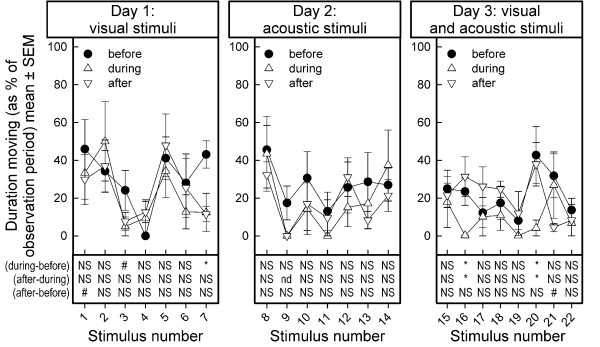
Average duration moving, before, during and after stimulus presentation in dairy goats. Duration moving is expressed as percent of the total observation period (mean ± SEM). Results of one-sample t-statistics on the difference scores between values (during - before), (after - during) and (after - before) stimulus presentation are summarized in the lower part of the figures. The list of stimuli presented is shown in Table 1. NS: no effect, p > 0.10; nd: not determined, because all observations are zero-values, i.e. no goat was moving during an observation period; #: marginal effect, 0.10 > p > 0.05; *: effect, p < 0.05